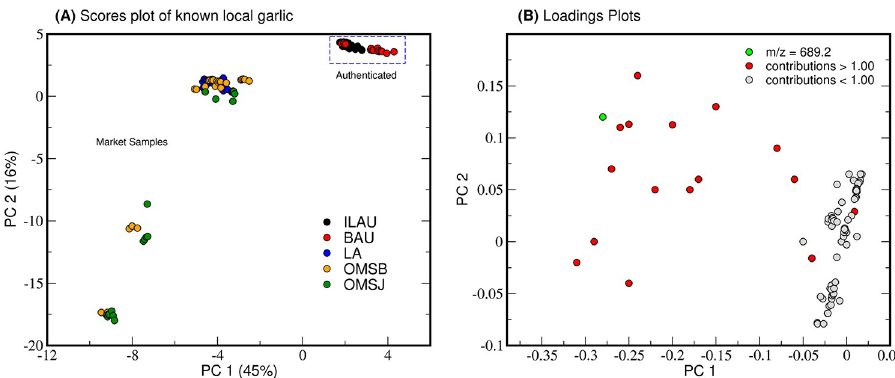
Fig 4. Multigroup comparison of known native garlic. Log-transformed PCA scores plot (A) shows that authentic garlic clusters distinctly from other local samples. Mindoro garlic OMSB and OMSJ share features that separate them from the rest of the samples. The variance observed from the samples can be attributed to primarily to metabolites such as oligosaccharide stachyose (m/z 689.2), and other unidentified features (red) as indicated by the loadings plot (B).